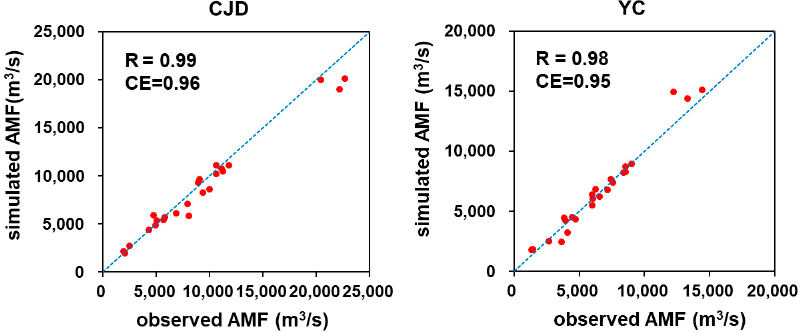
Figure 2. Comparison of observed AMF and simulated AMF. R indicates the coefficient of correlation and CE indicates the coefficient of efficiency. The blue dotted line indicates 1:1 line.